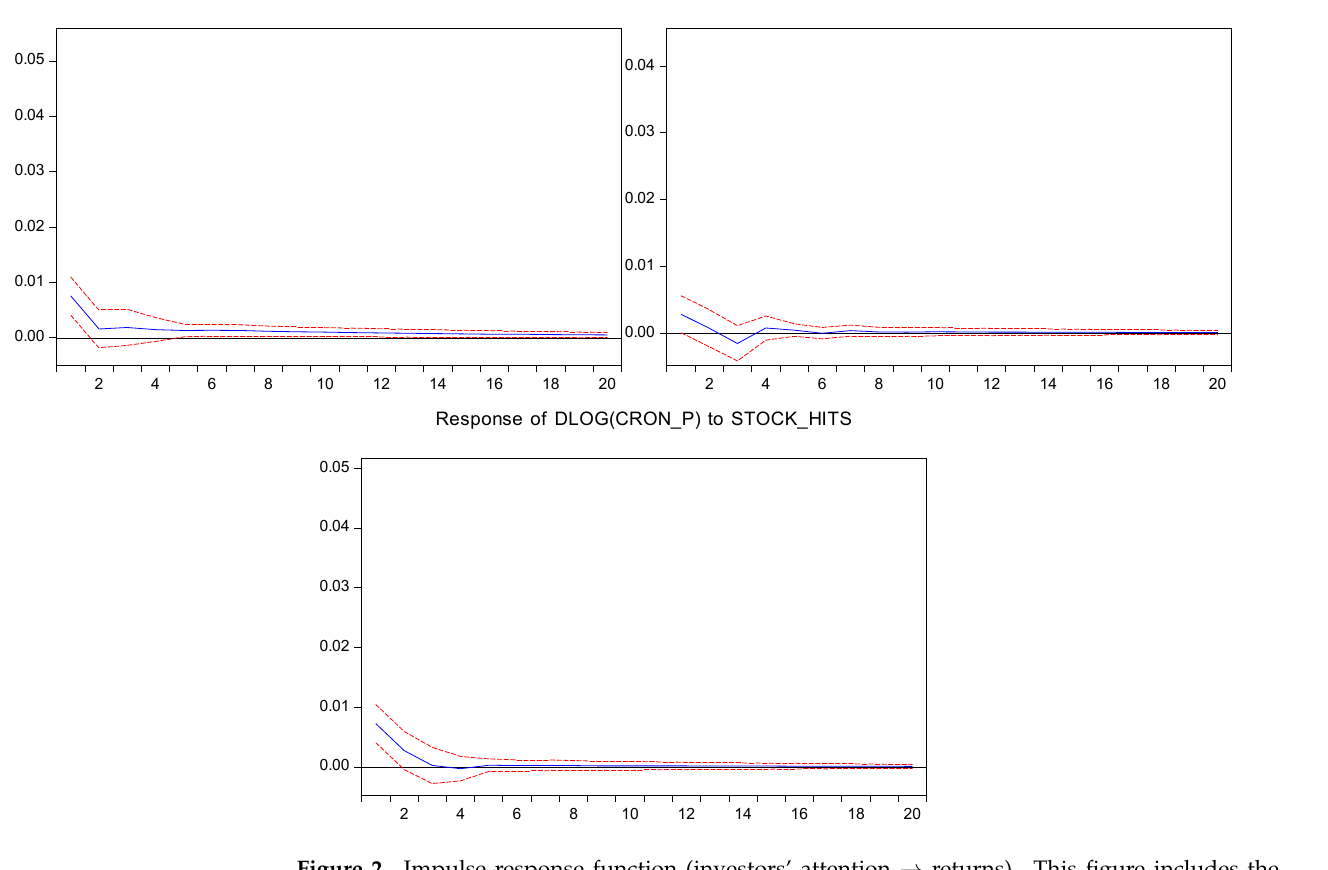
Figure 2. Impulse response function (investors’ attention → returns). This figure includes the generalized impulse response function in vector autoregressive (VAR) models studying the response of cannabis stock returns to shocks to investors’